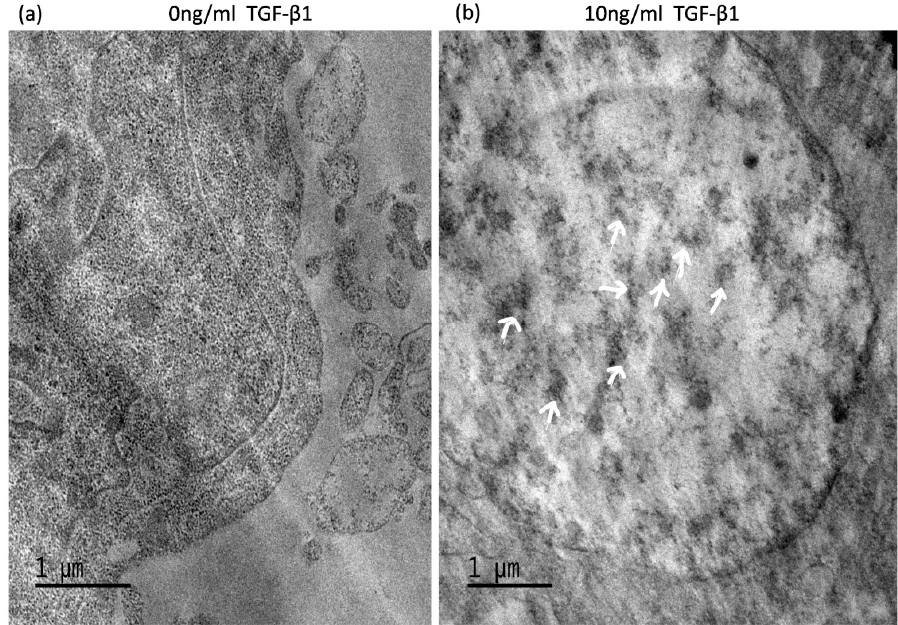
Figure 6. Electron microscopic appearance of protein aggregates. Control ( a ) and 10 ng/mL TGF- β 1 treated cells ( b ) were observed under electron microscope. One- µ m thin slices show protein aggregate localization (indicated by white arrows, ( b ) in 72 h, 10 ng/mL TGF- β 1 treated cells (original magnification ×50,000).